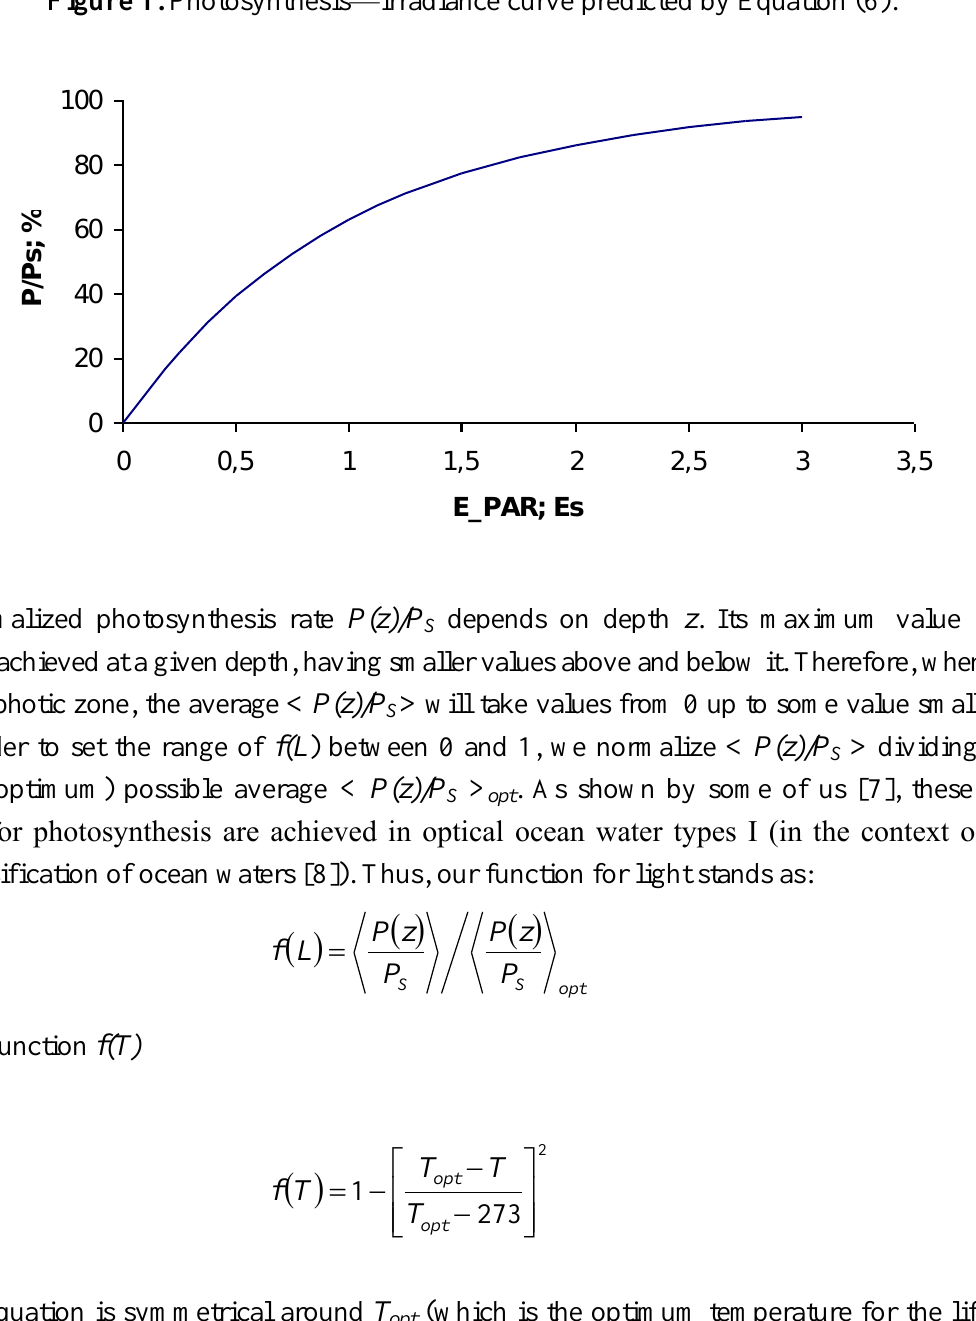
Figure 1. Photosynthesis—irradiance curve predicted by Equation